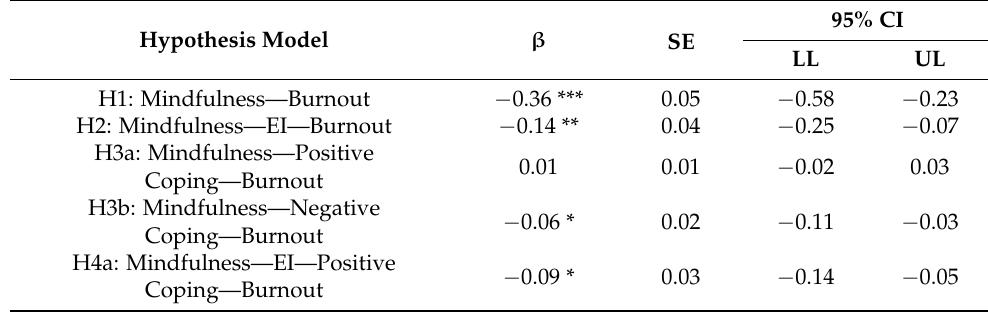
Table 2. Bootstrapping indirect effects and 95% confidence interval for the mediation model. Hypothesis Model